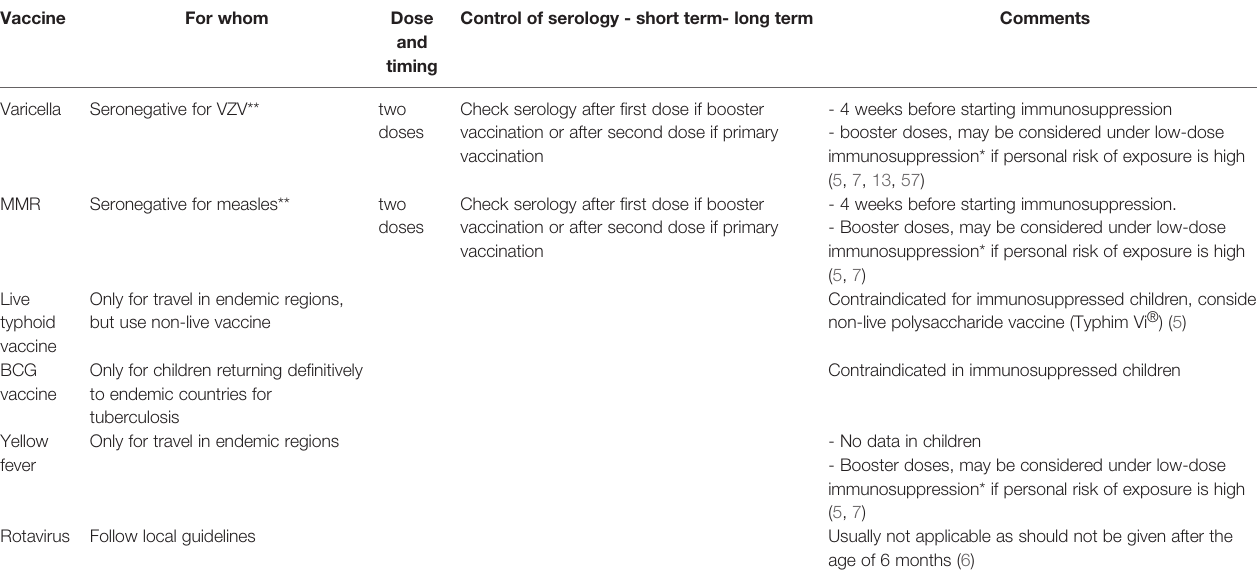
TABLE 3 | Recommendations for live vaccines. Vaccine For whom Dose